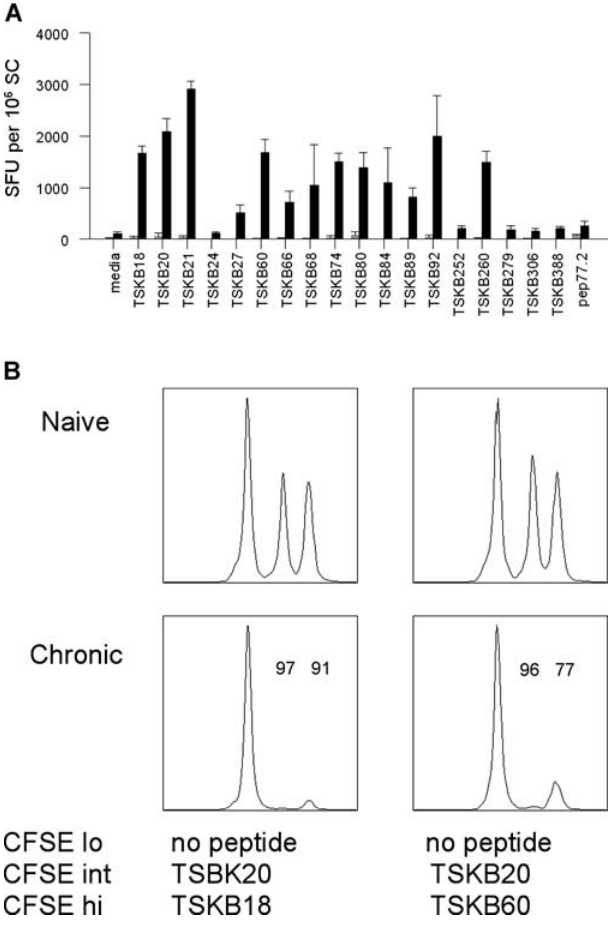
Figure 1. Functional Responses of Murine CD8 þ T Cells Directed against T. cruzi –Derived ts Peptides (A) SCs from naive (gray bars) or chronically infected (Brazil strain; black bars) B6 mice were stimulated overnight with ts peptides on anti-IFN c – coated ELISPOT plates as described in Materials and Methods. Error bars represent SD. Data represent the number of SFUs per 10 6 SCs plated. (B) SCs from naive B6 mice were loaded with T. cruzi peptides and labeled with CFSE as described in Materials and Methods. Cells were recovered from naive and infected mice 16 h after transfer and examined for CFSE fluorescence. The numbers above the peaks represent the percentage of specific killing for targets loaded with the respective peptide, and was calculated as described in Materials and Methods. Data are representative of eight experiments. DOI: